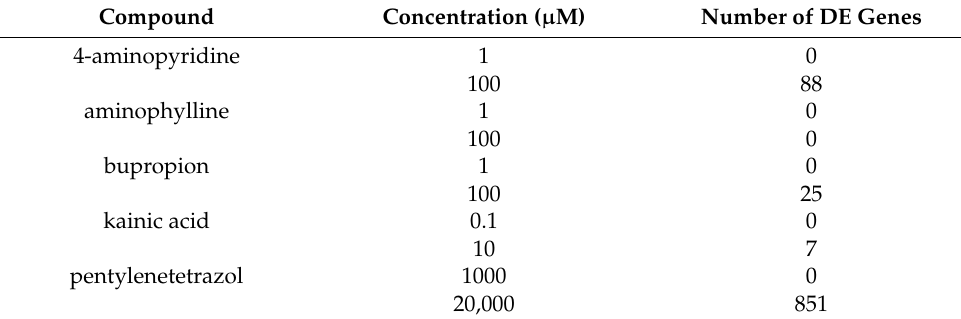
Table 1. Number of differentially expressed genes.